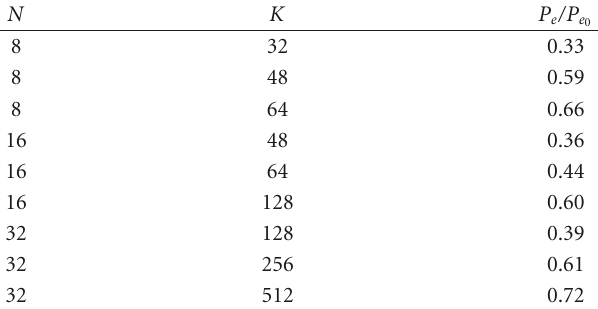
Table 3: The ratio P e /P e homogeneous clutter.